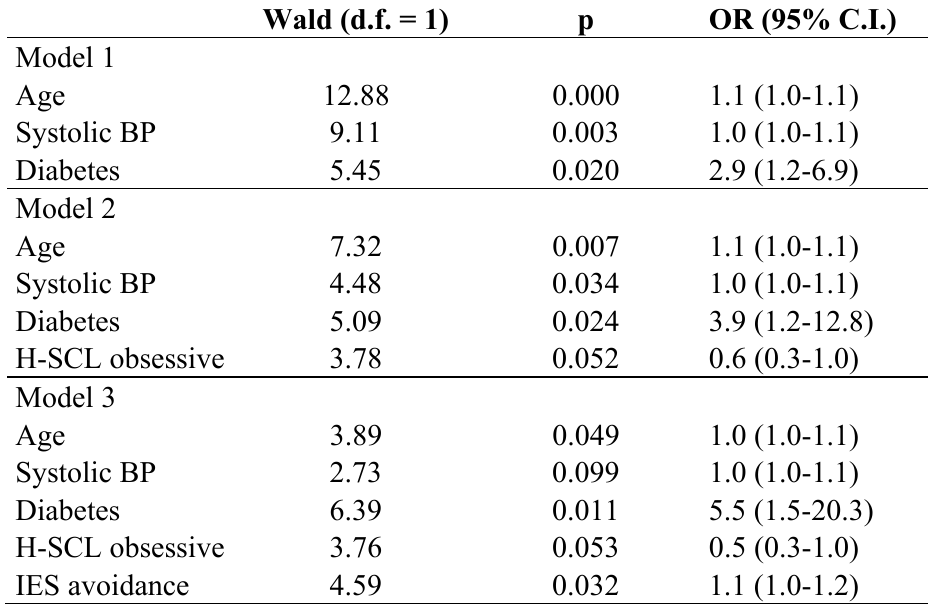
Table 3. Predictors of resistant hypertension (logistic regression